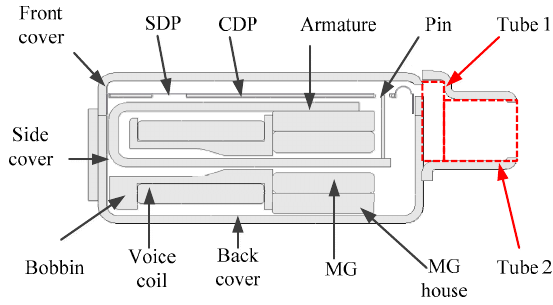
Figure 4. Acoustic modeling in the BAR.